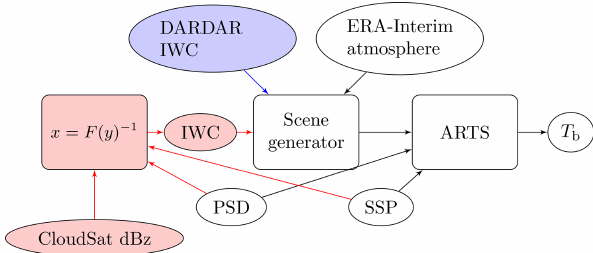
Figure 3. Flowchart describing the active and passive modelling system. White boxes and black arrows represent processes and data common to both variants of the system. The blue box and arrow are part of the IWC-based system; i.e. simulated TBs are generated using DARDAR IWC as input. The red boxes and arrows, on the other hand, describe the dBZ-based model system, for which the forward simulations use CloudSat reflectivities as input. As indi- cated by the red arrows from the PSD and SSP (single scattering properties) boxes, the dBZ-based system assumes the same micro- physics for both the radar inversion and the consequential forward